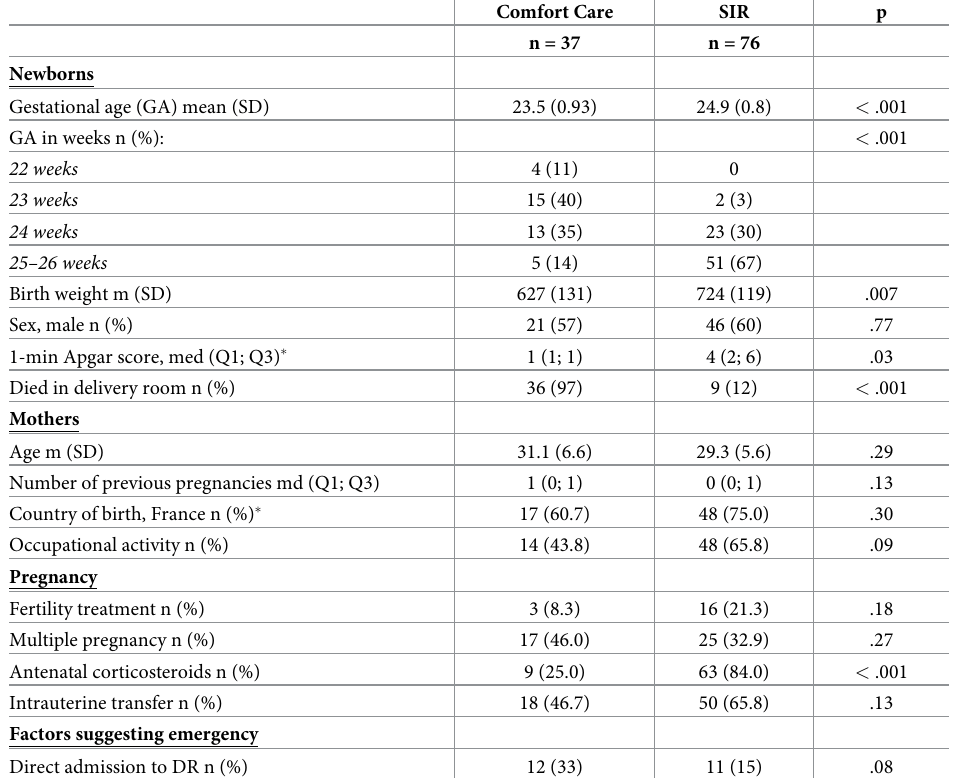
Comfort Care SIR p n = 37 n = 76